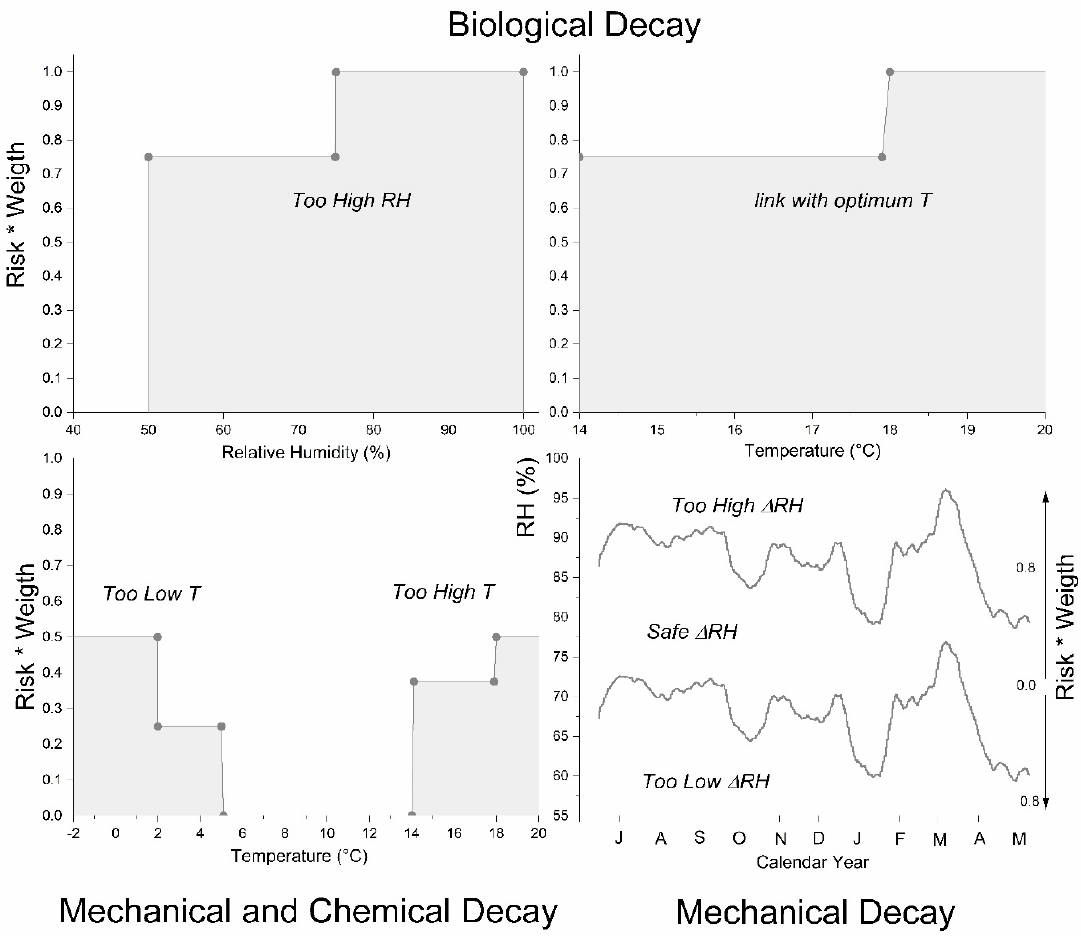
Figure 6. Conversion dose-response and/or threshold functions to prioritize the agent of decay and calculate the level of risk. (top-left) relative humidity (RH)-induced biological decay in the case of both RH-sensitive insects as woodworm and mold infestation with their link with temperature (T) conditions (top-right). Bottom-left: T-induced mechanical (too low T) and chemical risk of decay (too high T). Bottom-right: RH-induced mechanical decay caused by wider RH fluctuation than the historic climate as stated in the EN15757:2010 standard [26].